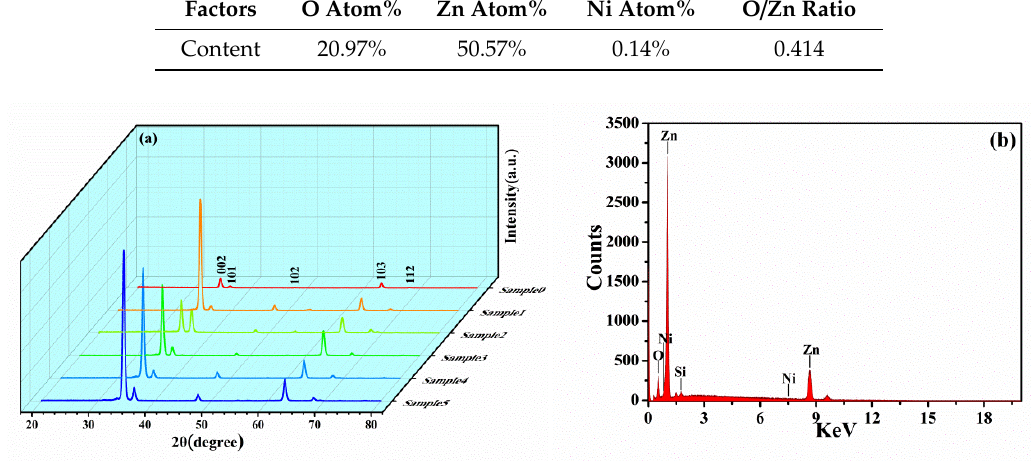
Figure 1. XRD ( a ) and EDX ( b ) of Zn 1-x Ni x O nanorod arrays.